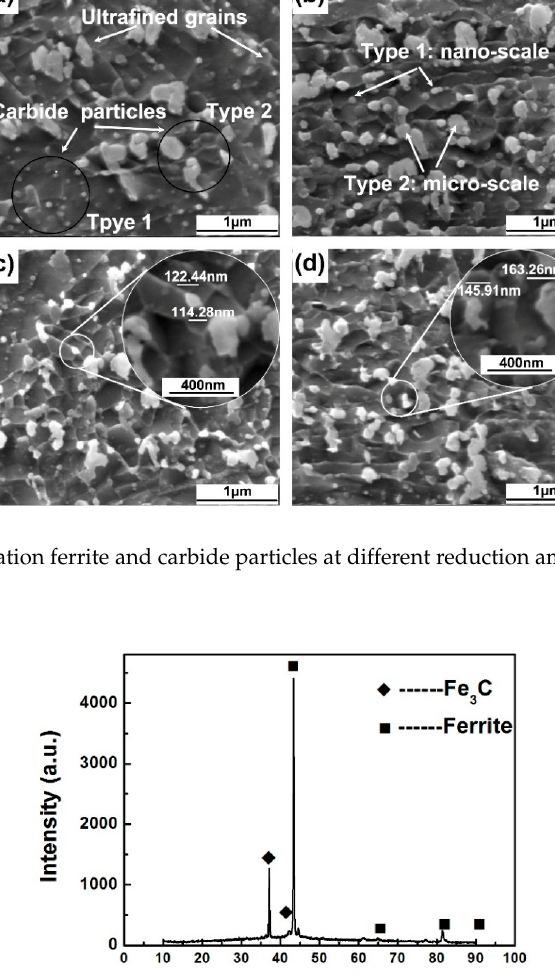
Figure 8. X-ray diffraction (XRD) results displaying the diffraction peaks of α phase (ferrite) and X 3 C.